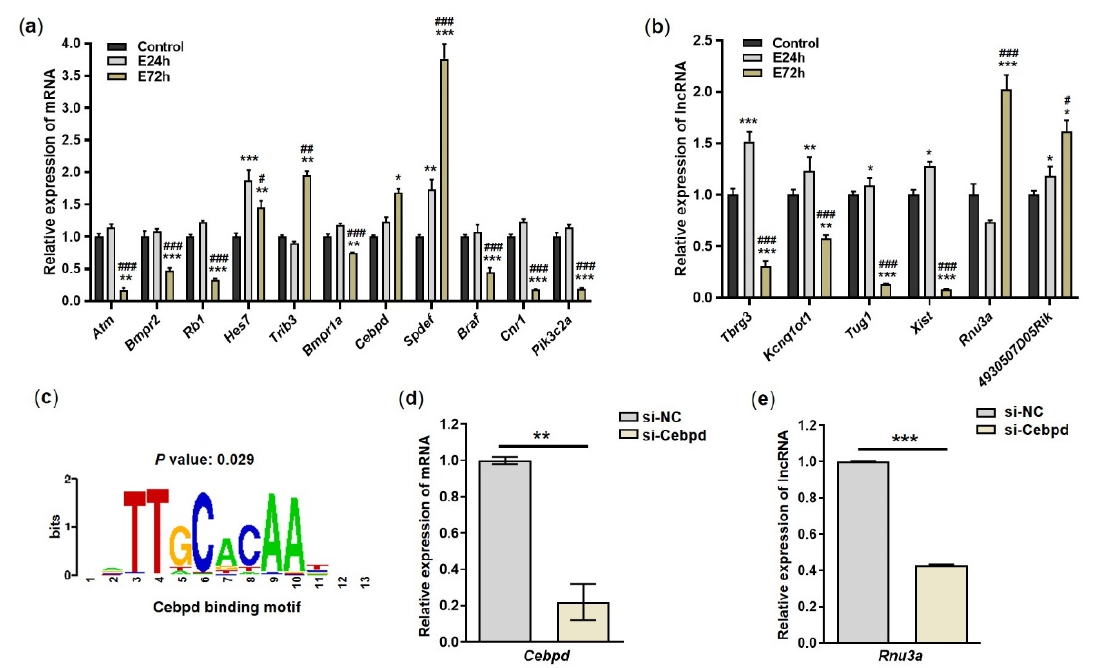
Figure 5. Validation of mRNAs and lncRNAs expressed differentially in Neuro2a exposed to ethanol. After exposing Neuro2a cells to 100 mM ethanol for 24 and 72 h, some mRNAs and lncRNAs were analyzed using RT-qPCR. ( a ) Expression changes of genes related to nucleic acid metabolic processes ( Atm , Bmpr2 , Rb1 , Hes7 , and Trib3 ), cellular macromolecule metabolic processes ( Bmpr1a , Cebpd , and Spdef ), and regulation of cellular metabolic processes ( Braf , Cnr1 , and Pik3c2a ). ( b ) Expression changes of lncRNAs. ( c ) Cebpd binding motif in the promoter region of lncRNA Rnu3a . ( d ) Expression of Cebpd after knock-down using siRNA targeting Cebpd (si- Cebpd ) and in a negative control (si-NC). ( e ) Expression of Rnu3a after knock-down of Cebpd using si- Cebpd and si-NC. *: significantly different from control in ( a , b ) and from si-NC in ( d,e ) (* p < 0.05, ** p < 0.01, and *** p < 0.001). # significantly different from E24h ( a , b ) ( # p < 0.05, ## p < 0.01, and ### p < 0.001).